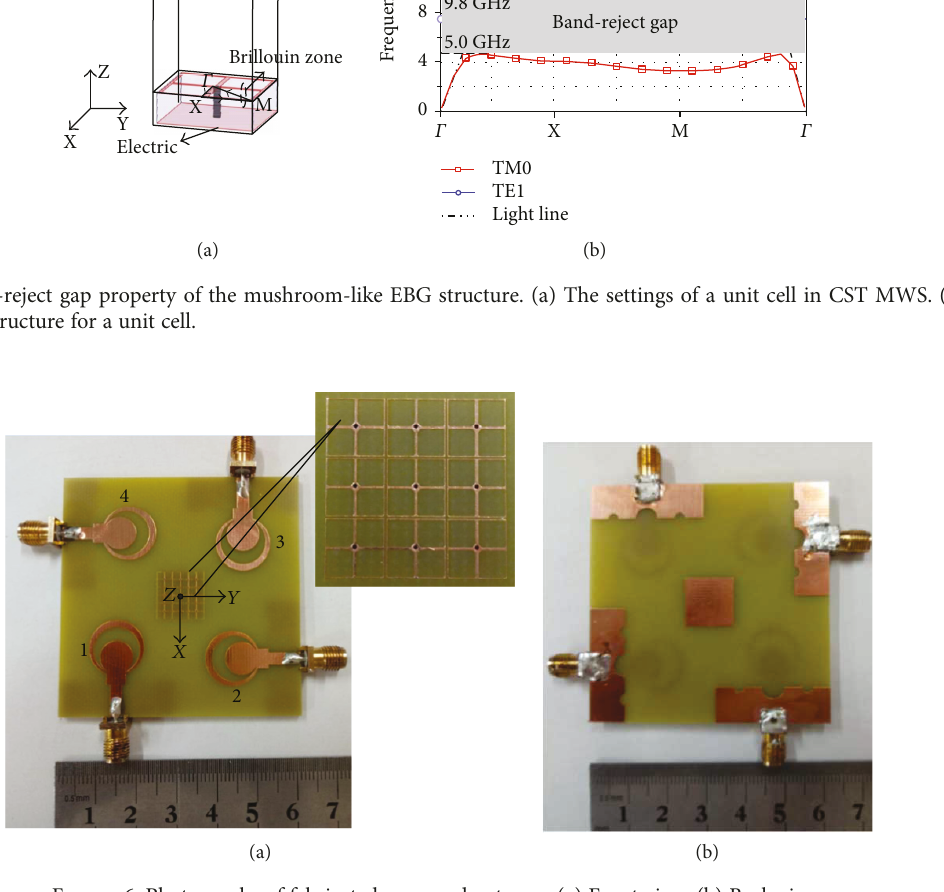
Figure 6: Photographs of fabricated proposed antenna. (a) Front view. (b) Back